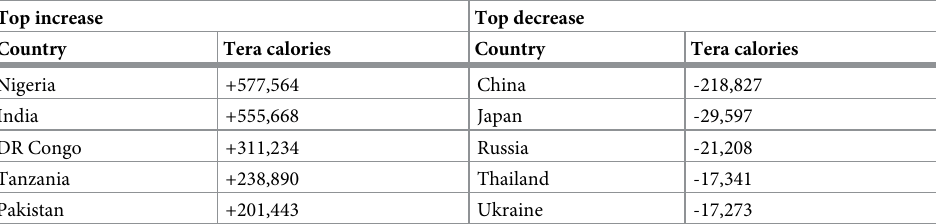
Table 2. Countries with the largest absolute change in calorie requirements in Scenario 4. Top